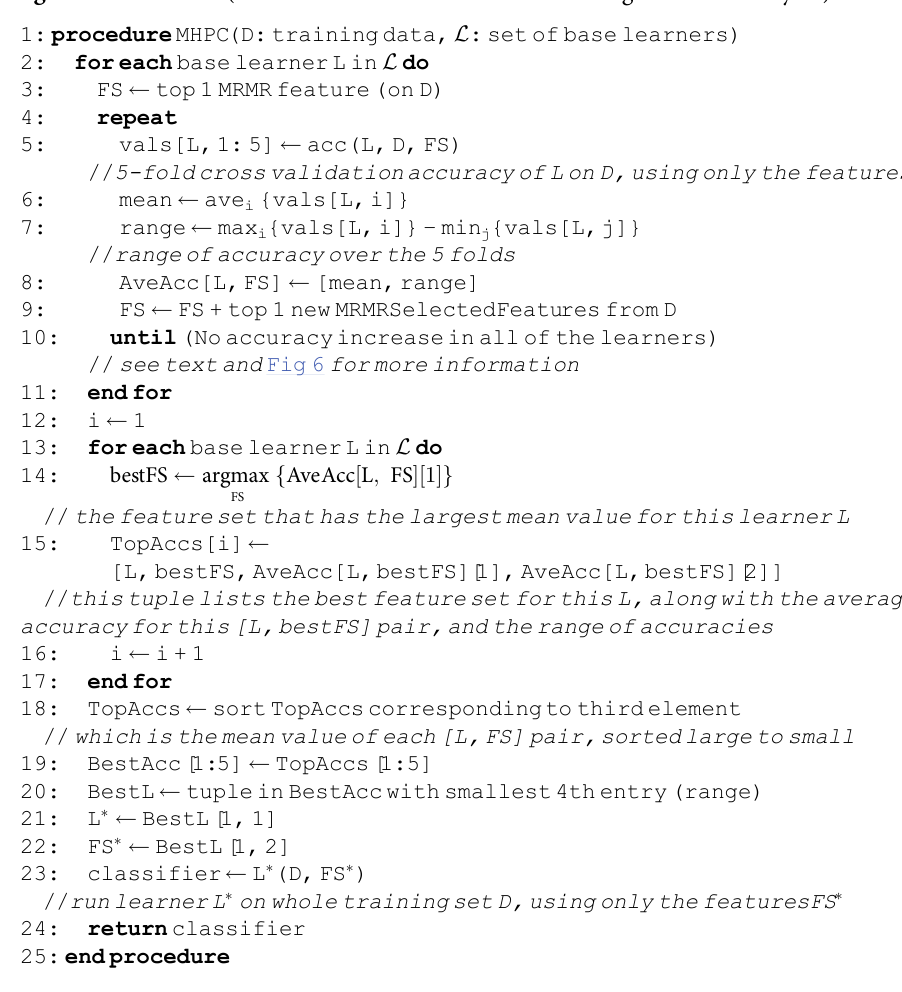
Algorithm 1: MHPC (see section Classifier for automated diagnosis for